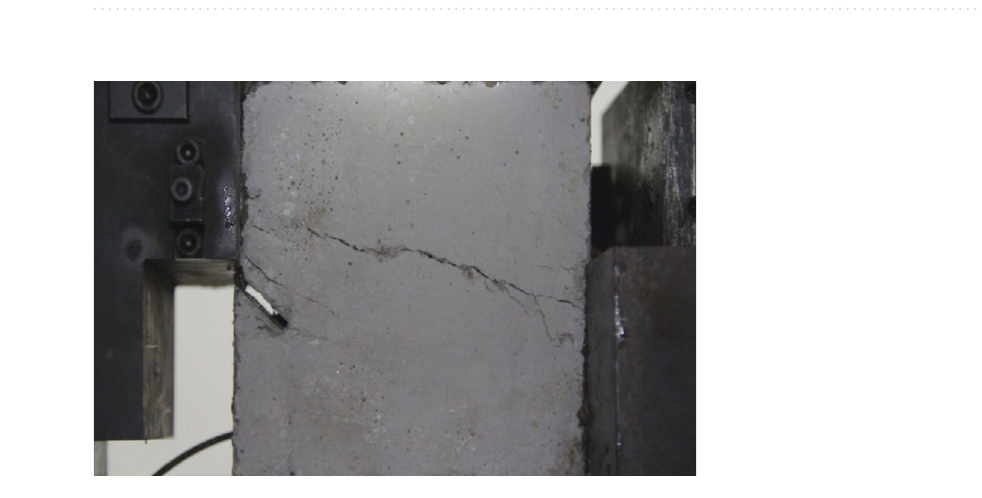
Figure 17. Photograph of a specimen showing fractures